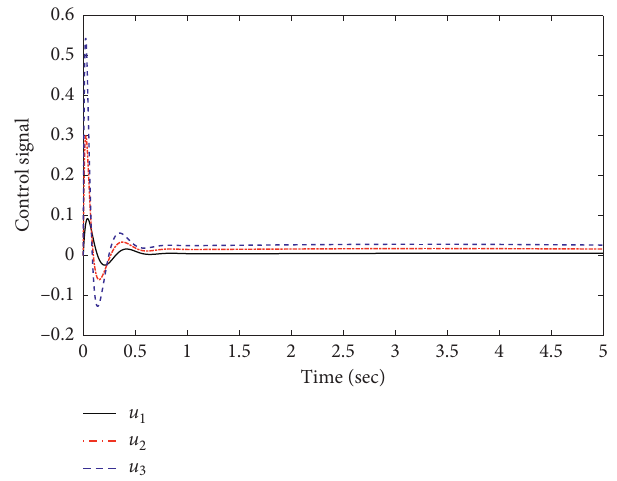
Figure 10: Control signal of the system under mismatched